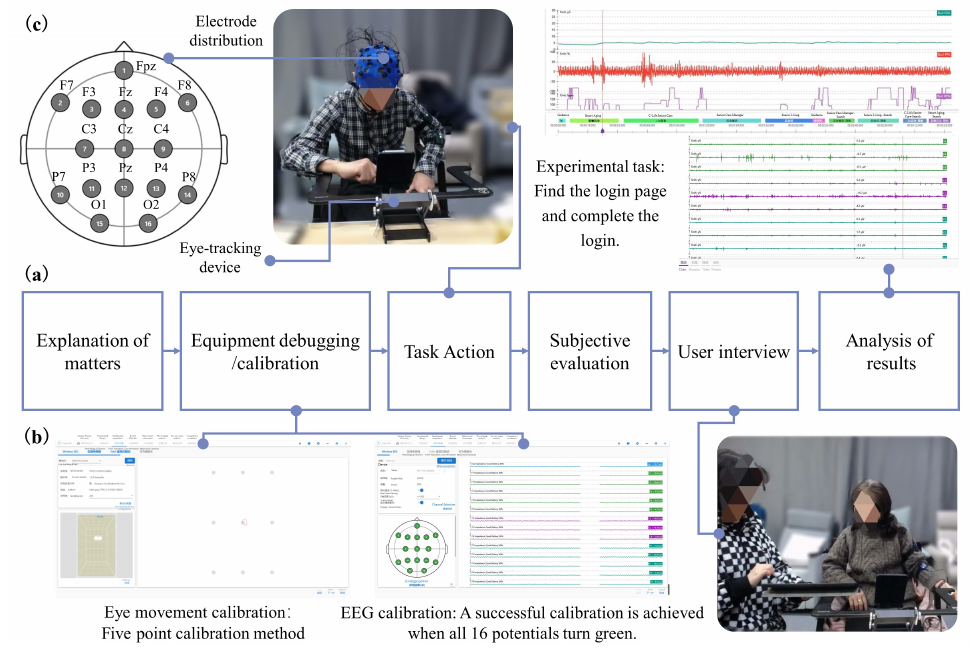
Figure 2. Experimental procedure for EEG recording and eye tracking: ( a ) The overall process of the experiment; ( b ) Instrument adjustment and calibration; ( c ) User experiment